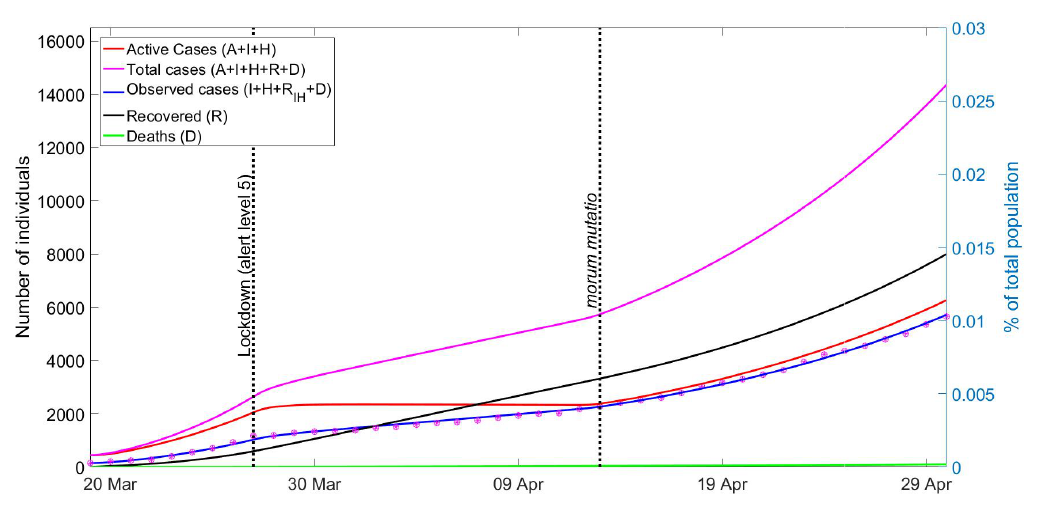
Fig. 4. COVID in South Africa: morum